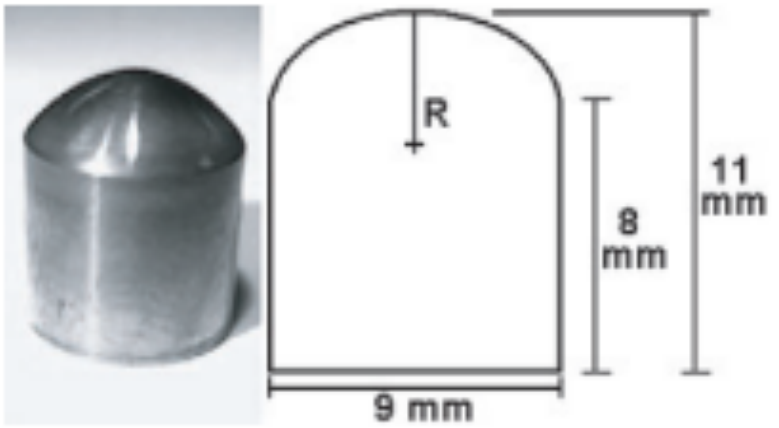
Figure 2. Left : Photo of a TMJ simulant with a 3 µ thick nanostructured diamond coating. Right : dimensions of the TMJ simulant. The radius of curvature (R) is 6 mm (From Ref. [79]).